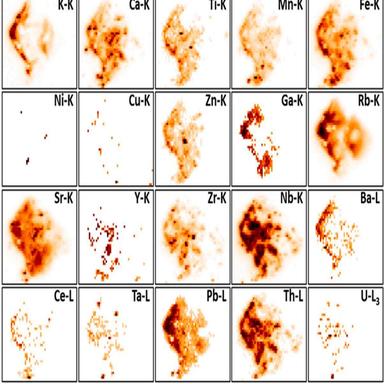
μ-XRF elemental maps of a soil particle from the Søve site, showing the presence of both Th and U as well as range of metals. Map size 2650 � 2000 μm2, stepsize 50 μm, 1 s per pixel.